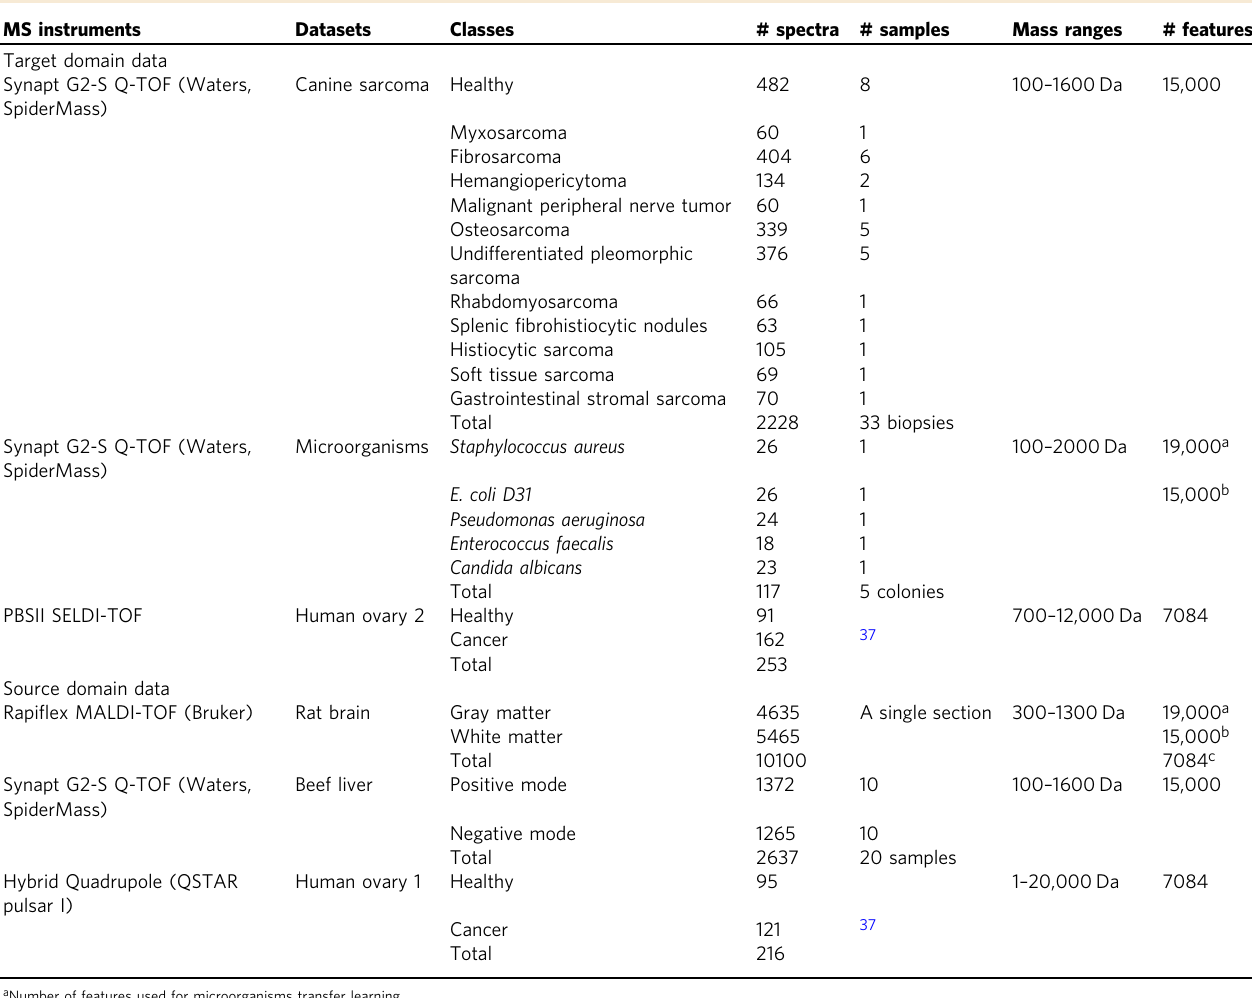
Table 6 Description of